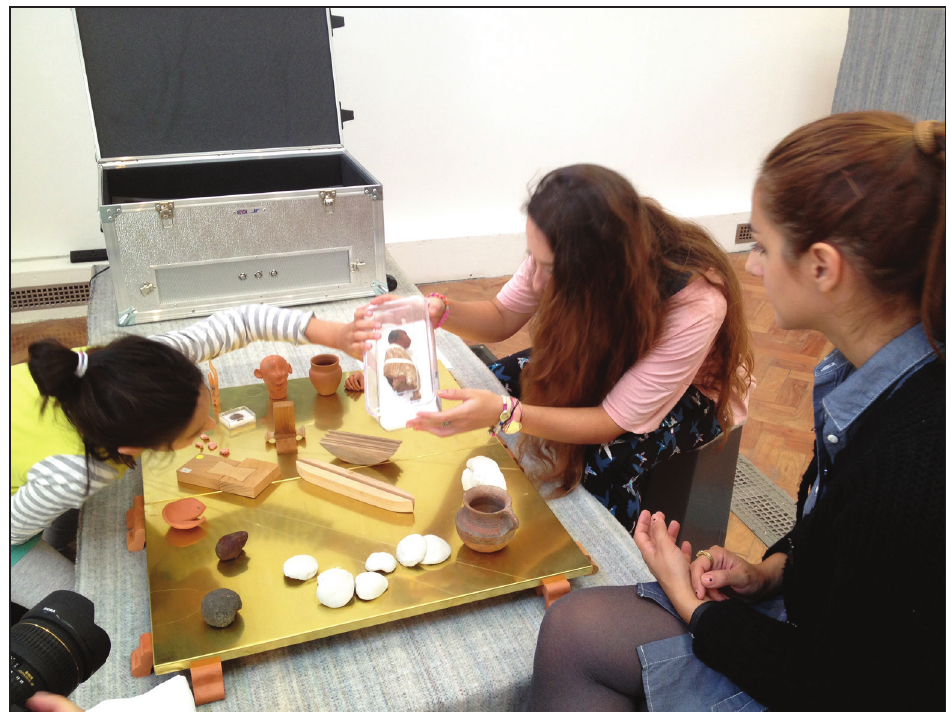
Figure 1: Object 18 (the boatman) being handled as part of Play for a Handling Collection , during the Crafts Council Exhibition Crafting Narrative (Photo Cecilie